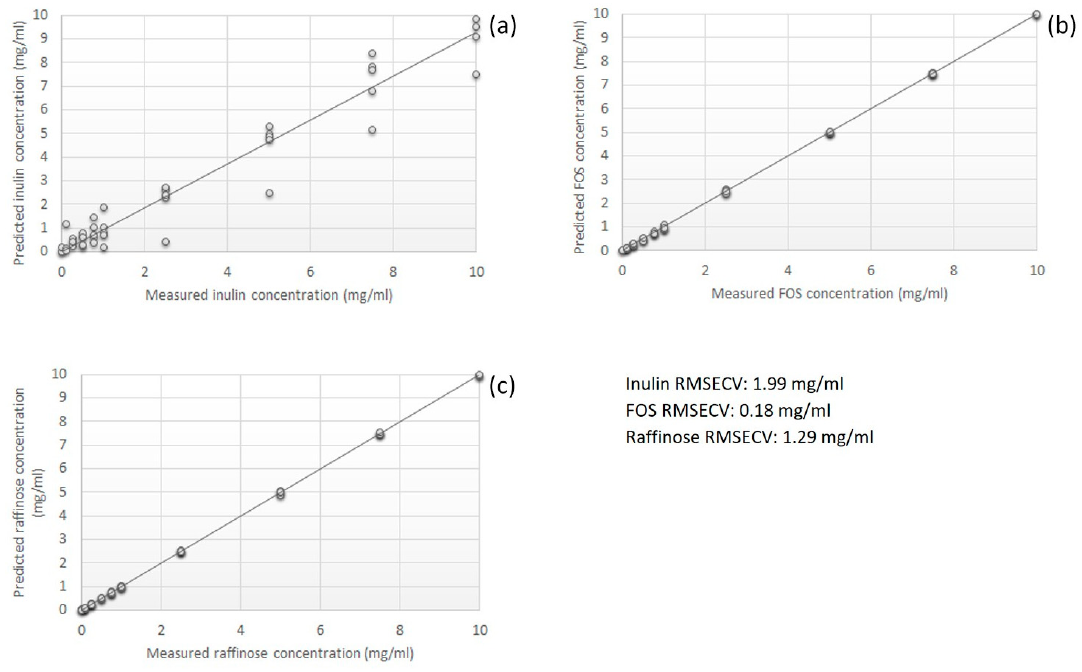
Figure 1. Calculated PLS-DA model for the prediction of ( a ) inulin, ( b ) FOS and ( c ) raffinose chemical standard liquid solutions.